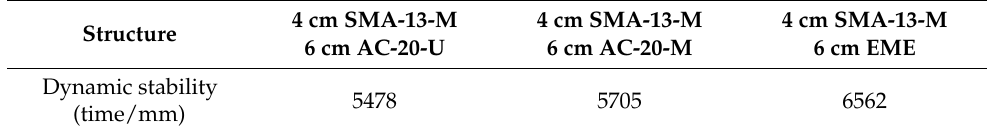
Table 1. Pavement structure scheme.